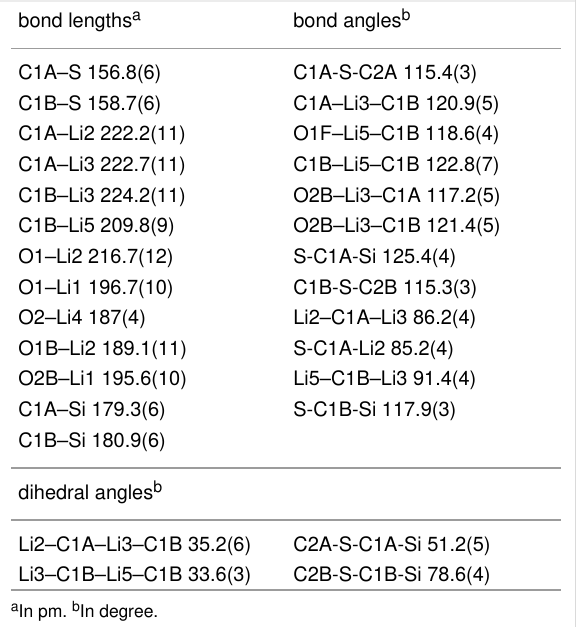
Table 1: Selected bond lengths, bond angles, and dihedral angles of ( 2a ) 4 ·(THF)